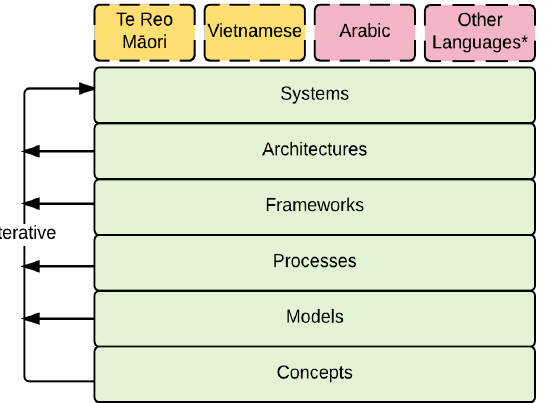
Figure 3. Framework of generic design elements to preserve and learn endangered languages